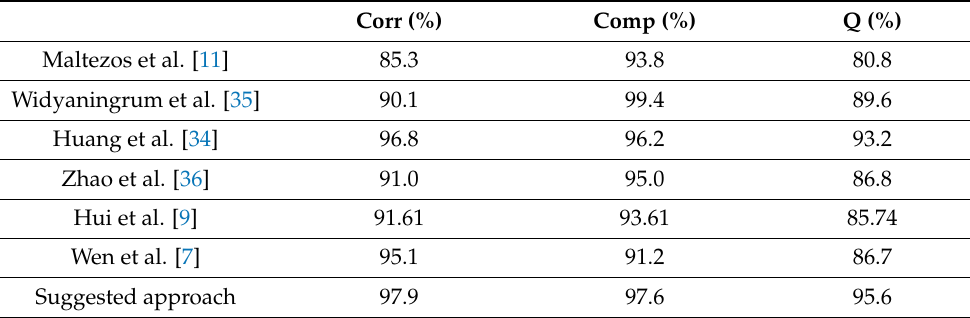
Table 4. Accuracy comparison of suggested approach with previous studies. Corr (%) Comp (%) Q